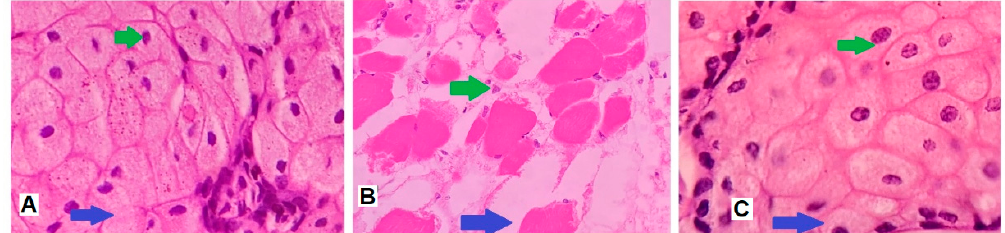
Figure 10. Light microscopic examination of sheep nasal mucosa stained using hematoxylin and eosin stain. ( A ) Negative control: nasal mucosa treated with phosphate buffer shows undamaged nasal cells with unimpaired basement membrane (blue arrow), intact glandular cells with a well-defined nucleus (green arrow). ( B ) Positive control: mucosa treated with isopropyl alcohol illustrates widespread destruction of nasal tissues including the injury to the basement membrane (blue arrow) and glandular cells (with consequent loss of nucleus) (green arrow). ( C ) Test: nasal tissue exposed to rivastigmine drug demonstrates unharmed basement membrane (blue arrow), undamaged glandular cells with distinct nuclei (green arrow).